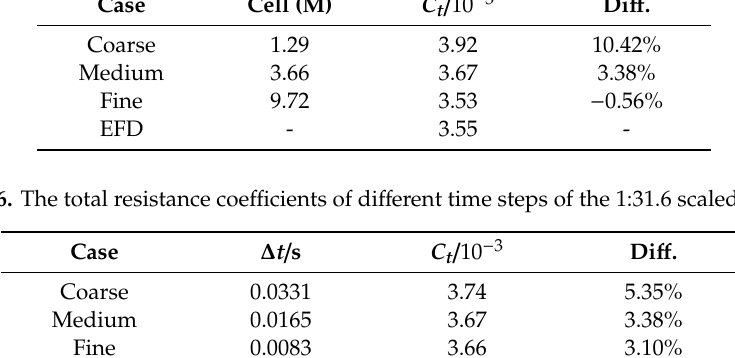
Table 5. Total resistance coe ffi cients of di ff erent grid cases of the 1:31.6 scaled model. Case